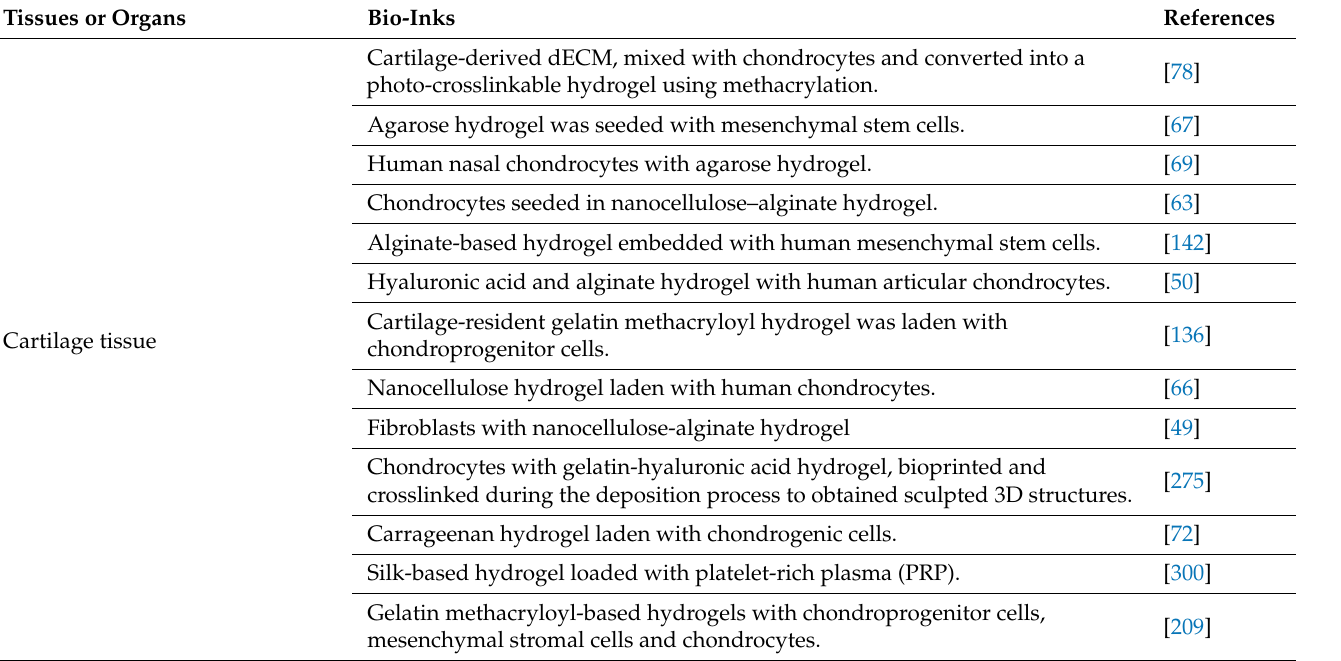
Table 4. Application of natural hydrogel-based bio-inks in the regeneration of several types of damaged